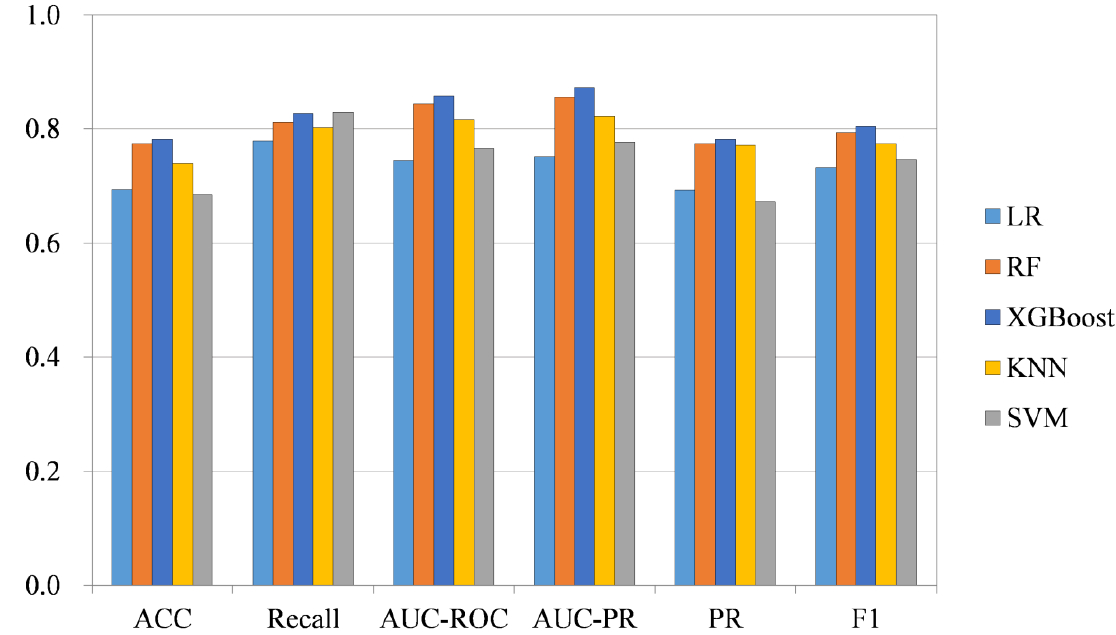
Figure 2. Classification method comparison. The five colors in the figure represent the five respective methods, the horizontal axis represents the performance index, and the vertical axis represents the corresponding value. Of the six indicators, XGBoost shows its superiority.